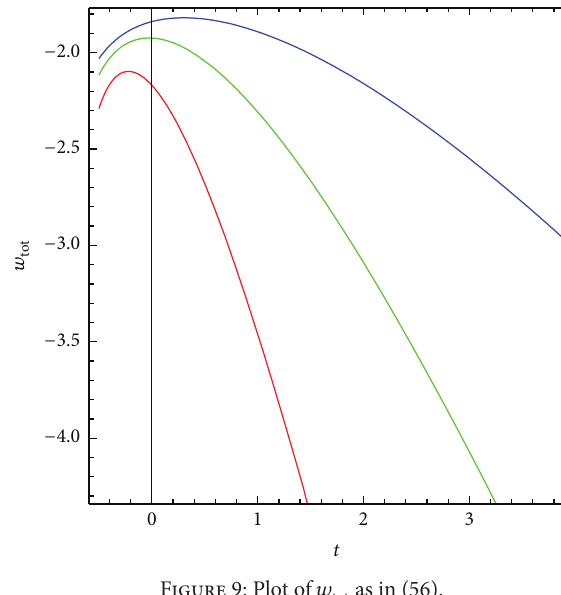
Figure 9: Plot of 𝑤 as in (56). tot